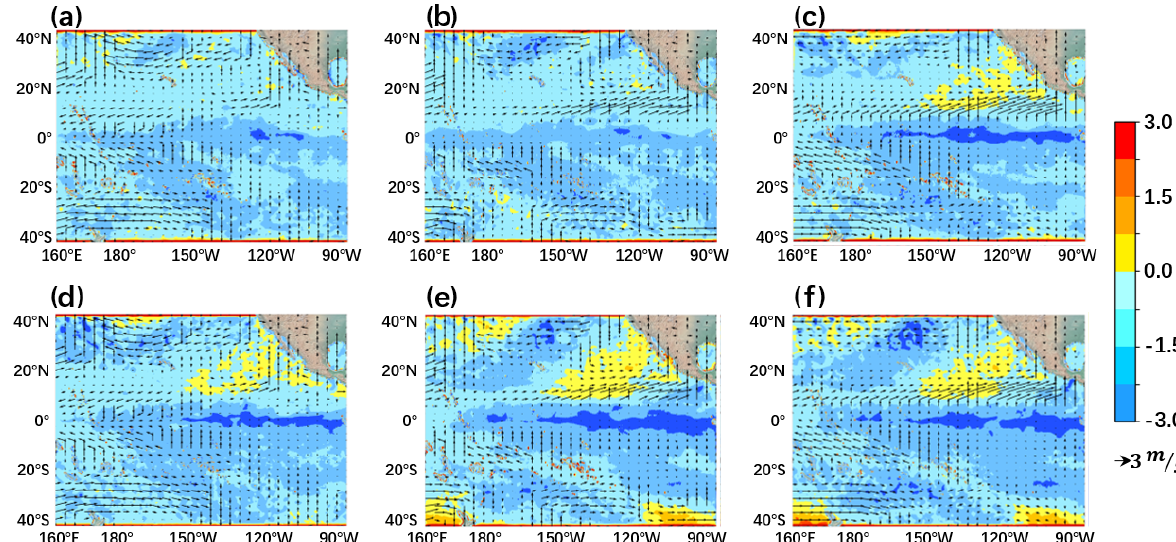
Figure 19. The same with Fig. 17 but for the growth phase of SST and wind anomalies of 2017 weak La Niña event from September to November 2017.